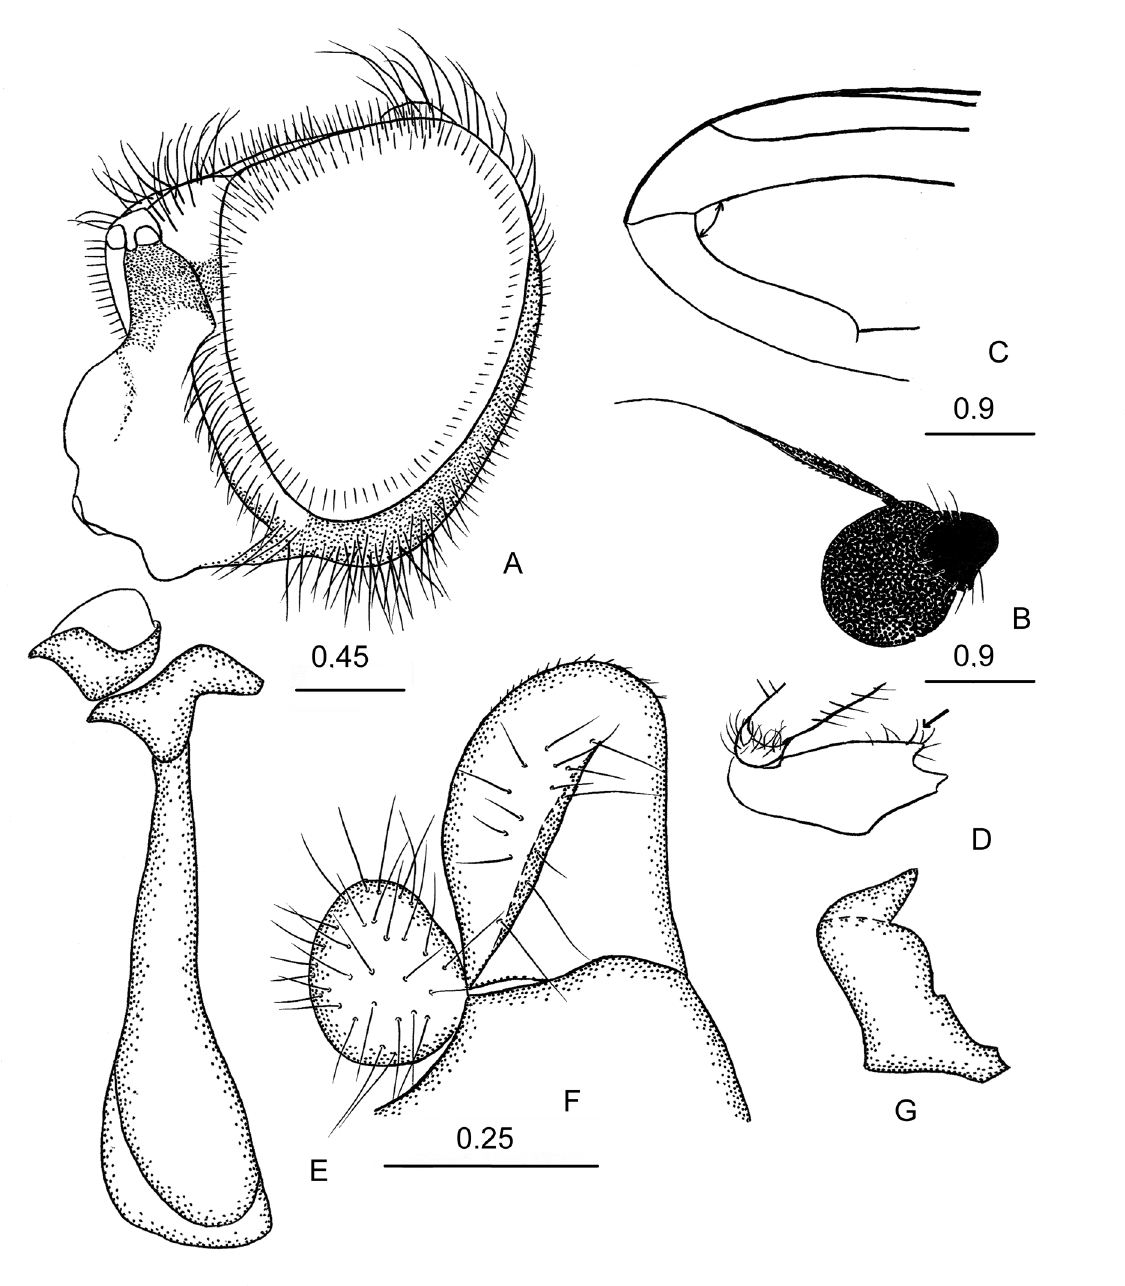
Fig. 60. Cheilosia ( Cheilosia ) spuria sp. nov., holotype, ♂ (CSCA). A . Head, lateral view. B . Antenna, lateral view of pedicel and basoflagellomere. C . Tip of wing. D . Fore coxa, with arrow indicating baso- lateral spur. E . Aedeagus and aedeagal apodeme, lateral view. F . Surstylus and gonocercus, lateral view. G . Superior lobe of hypandrium, lateral view. Scale bars indicated in